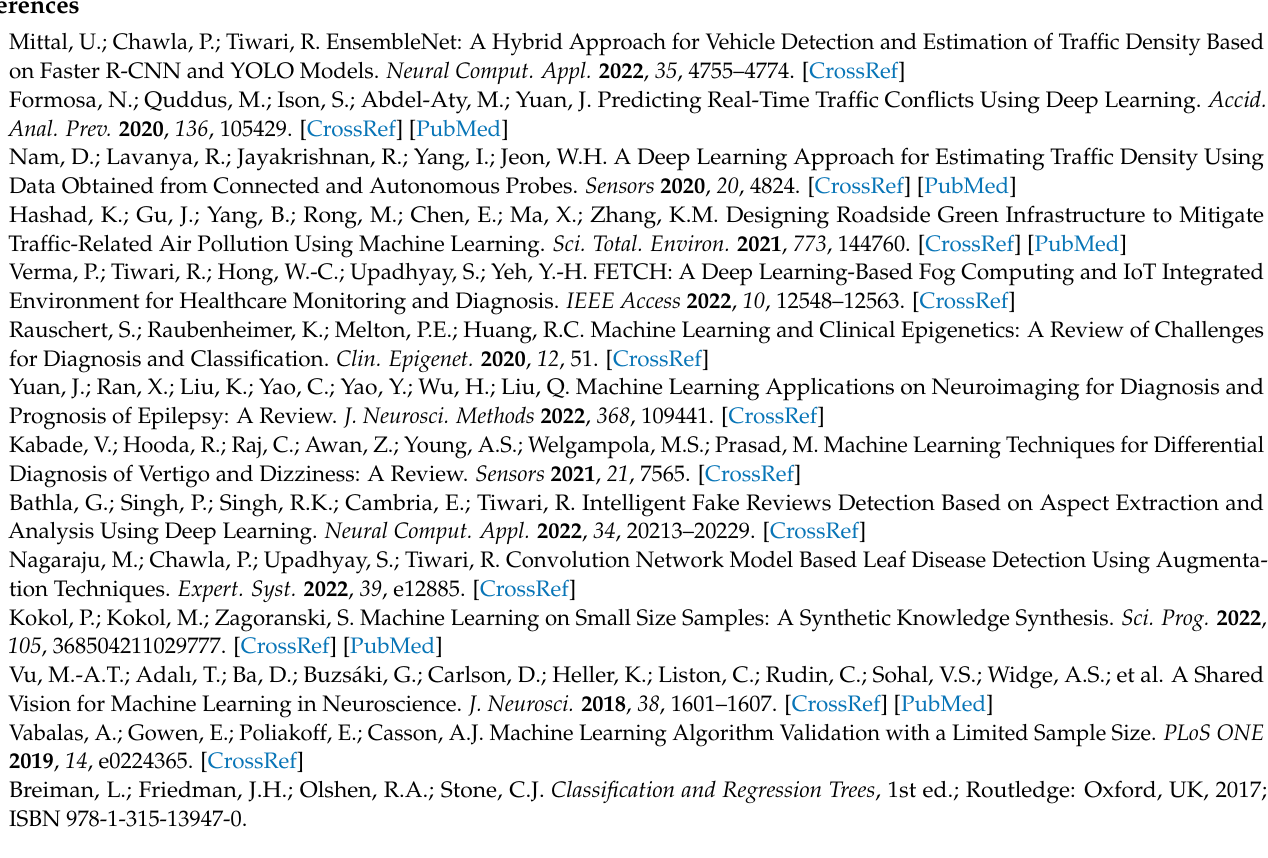
composition. Table S2. List of primary and secondary antibodies used to stain plated cells. Table S3. List of the predictors we used to estimate the LMNB1 class of the